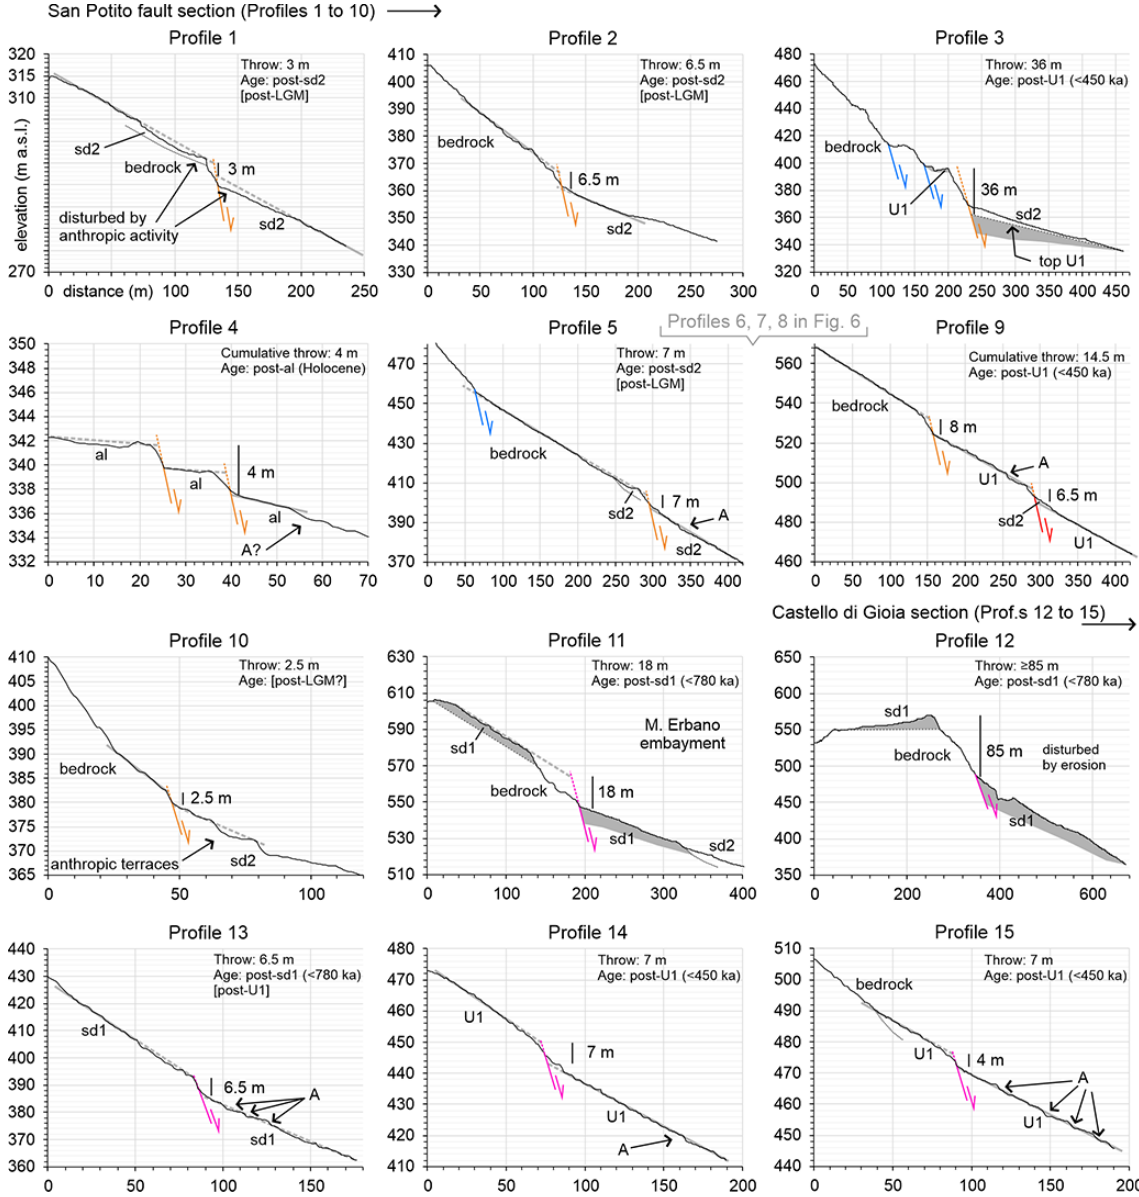
Figure 7. Topographic profiles across the Gioia Sannitica normal fault trace extracted from the 1m resolution lidar DEM. The points indicated with “A” show small anthropogenic terraces or excavations (which do not significantly modify the mean slope profile). Fault colours are the same as in Fig. 4 (constraints on fault activity). The preferred age of faulting, reported in square parentheses, for profiles 1, 2, 5, and 10 is based on comparison with fault scarps in Fig. 6. The preferred age for profile 13 is based on similarity with scarps in profiles 14 and 15. The estimated slip rates are reported in Table 3. The locations of profile traces are given in Fig.